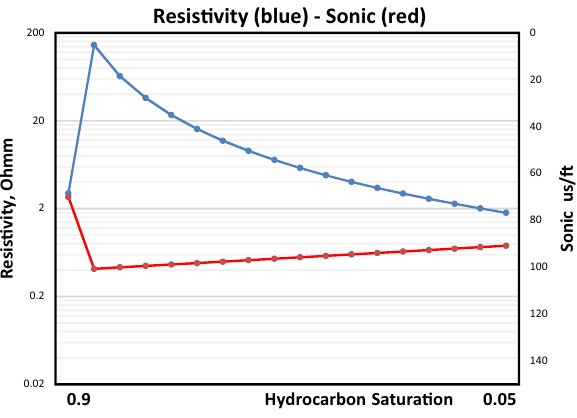
Fig. 3 Sonic–resistivity overlay, V